Question: Compose a caption that would accompany this figure in a paper.
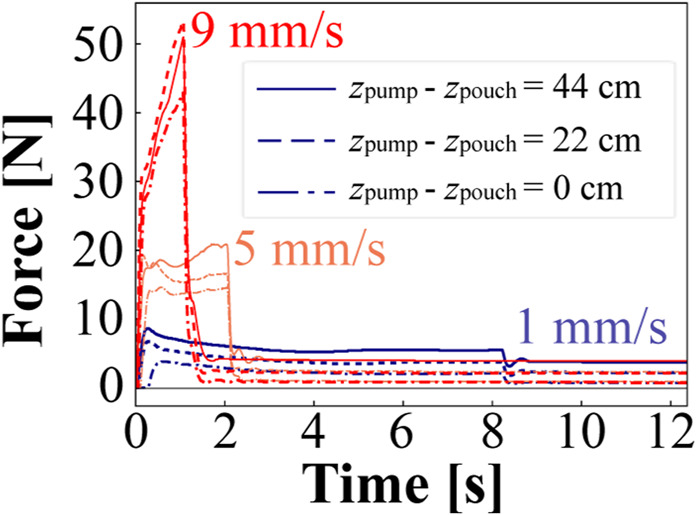
Answer: Time course of contact force on pouch without endoskeleton.